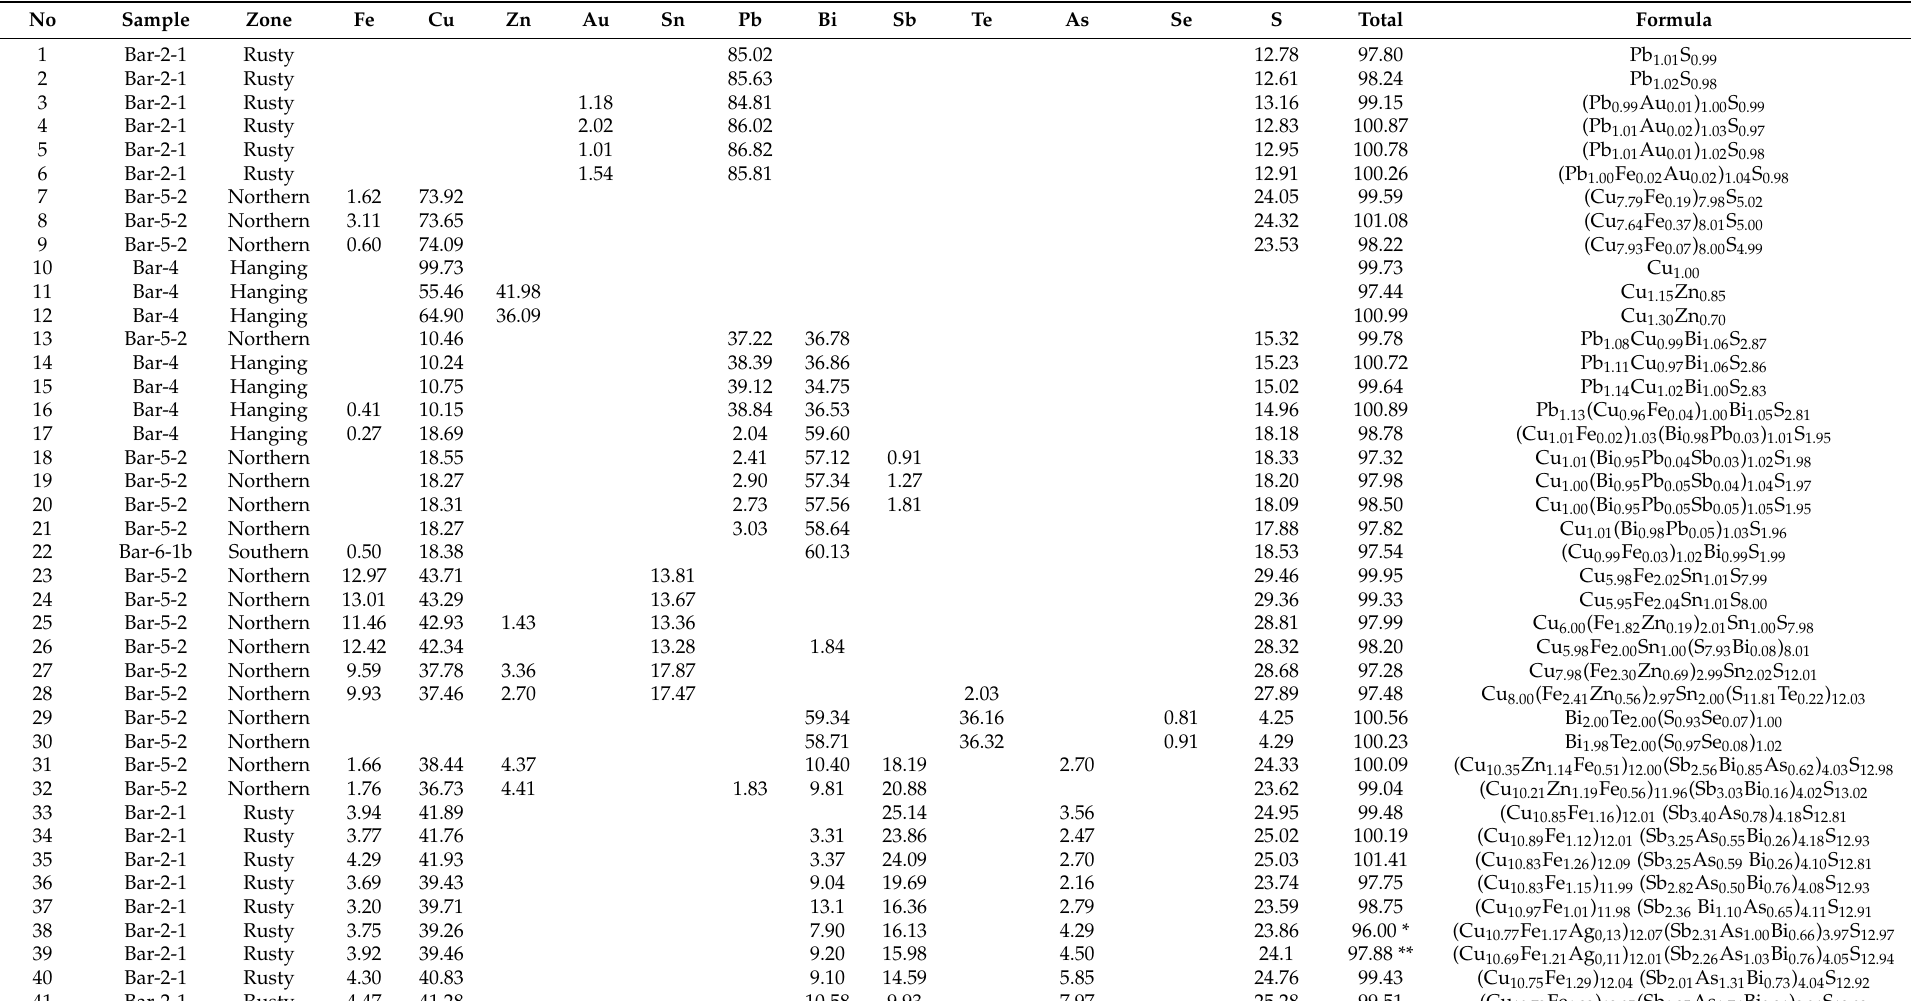
Table 5. Composition of minerals from the gold-sulfosalt-quartz association, wt.